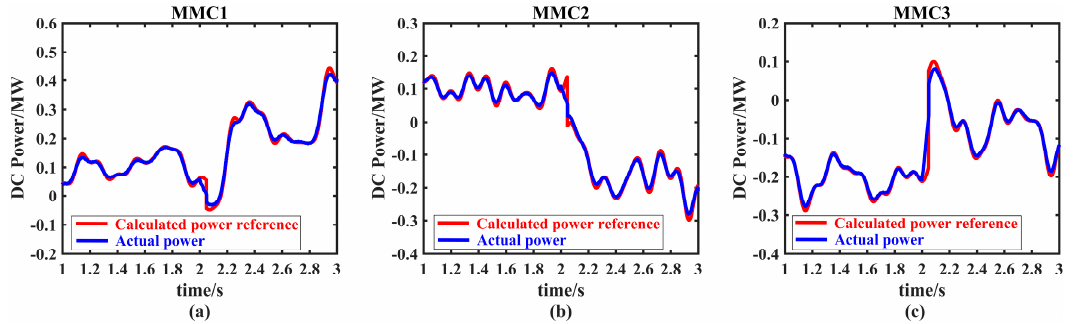
Figure 14. Calculated and actual power of the MMCs. (a) MMC1; (b) MMC2; (c) MMC3.